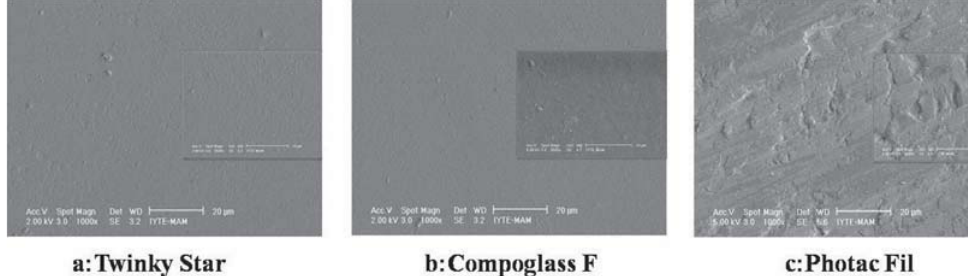
Figure 2- SEM micrographs of the specimens after polishing